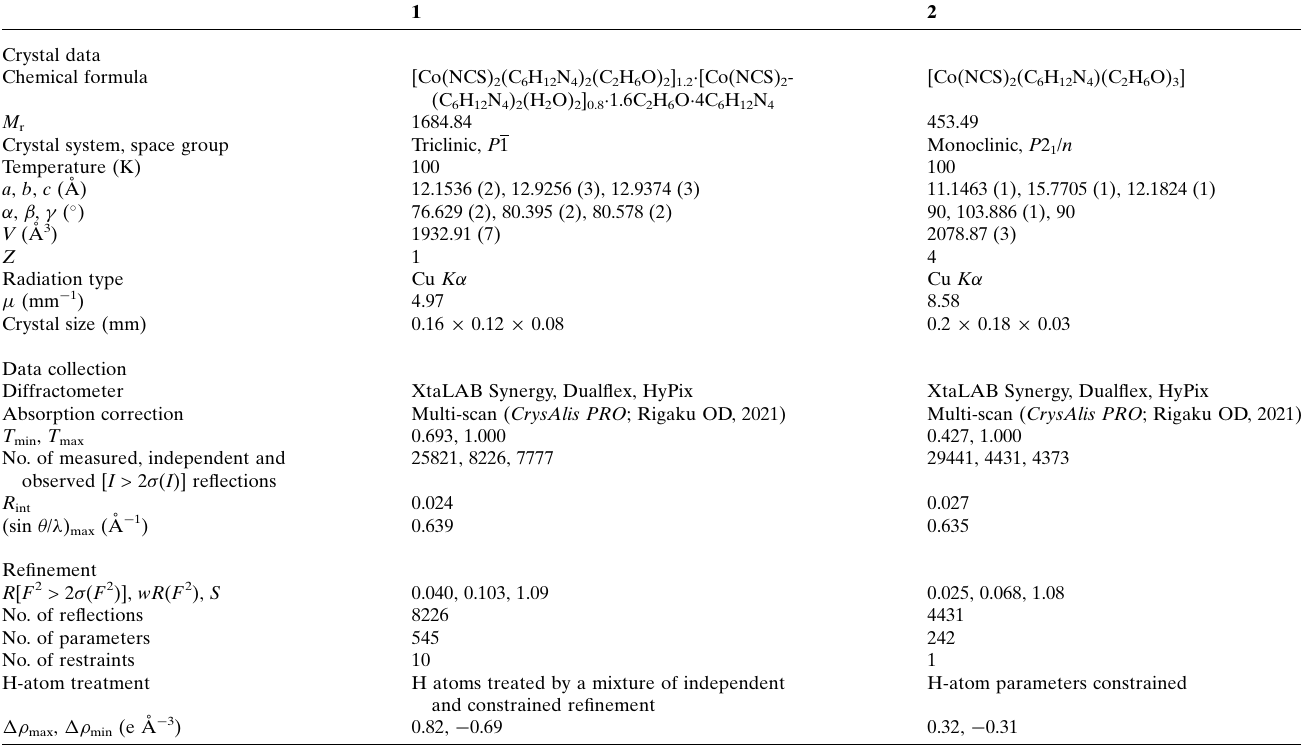
Table 5 Experimental